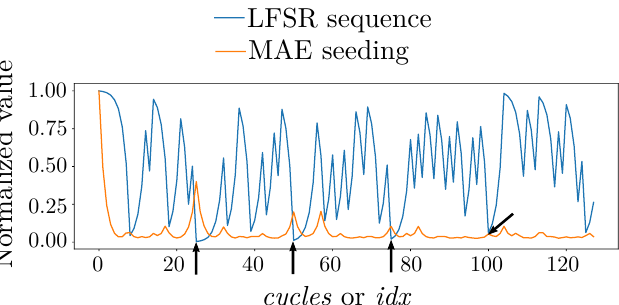
Figure 5. Resonant seeds (marked by arrows) produced by values which are more correlated with respect to the first seed index. There exist some correlated patterns in the LFSR sequence (blue line), which produce high correlation between stochastic signals, thereby inducing higher MAE (orange line).